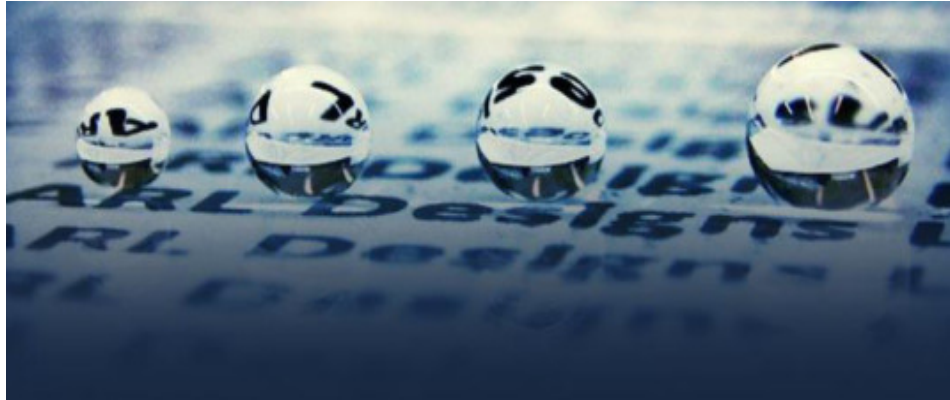
Figure 35. Super hydrophobic coating [147].